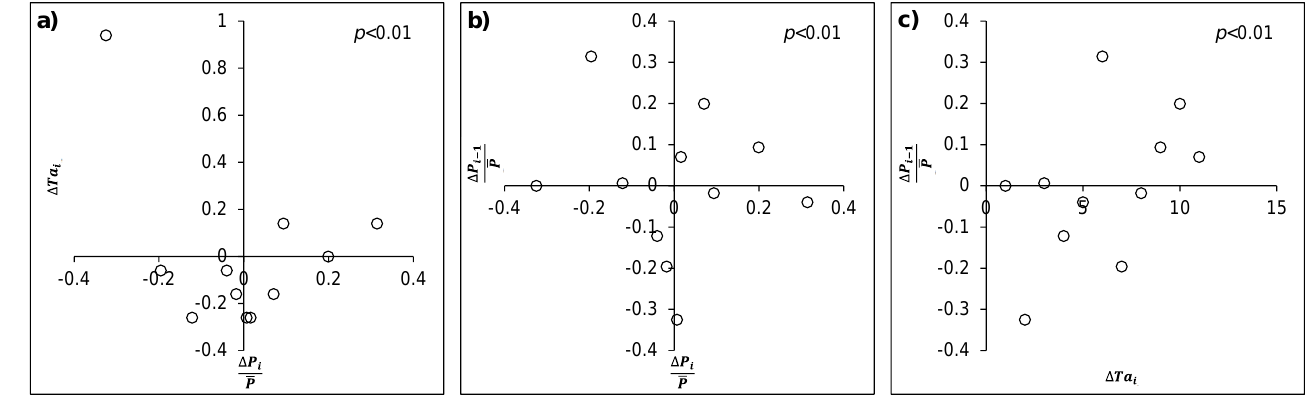
Figure B1. Regression between various climatic variables: ( a ) ∆𝑇𝑎 𝑖 vs. ∆𝑃 𝑖 Figure A1. Regression between various climatic variables: ( a ) ∆ Ta i vs. vs. ∆𝑇𝑎 𝑖 . No clear correlation/collinearity were found.